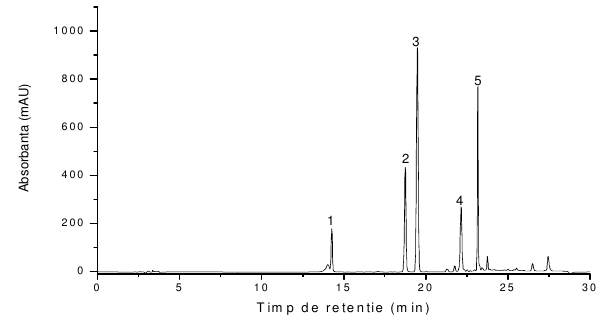
Fig. 3. Lignans standard chromatogram: 1-SDG; 2-SECO; 3- LARI; 4-PINO; 5-MATA (for abbreviations see Tab. 3)